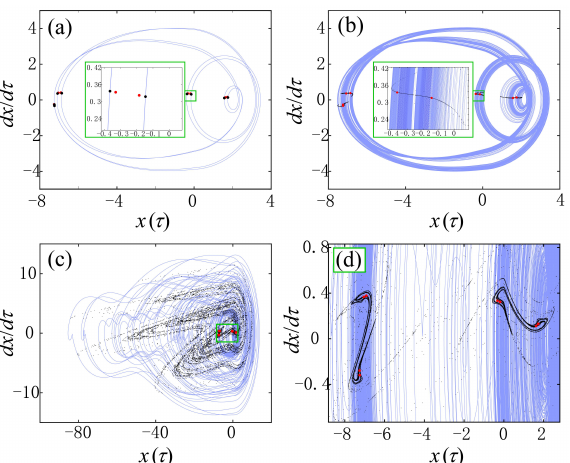
Figure 11. Phase portraits and their Poincare mappings of one-sided contact system for ω = 1, ( a ) A = 1.7798, ( b ) A = 1.78, ( c ) A = 1.785, and ( d ) the enlargement of ( c ), where the red dots denote the Poincare mapping of unstable period-8 motion at A 7 point (see Figure